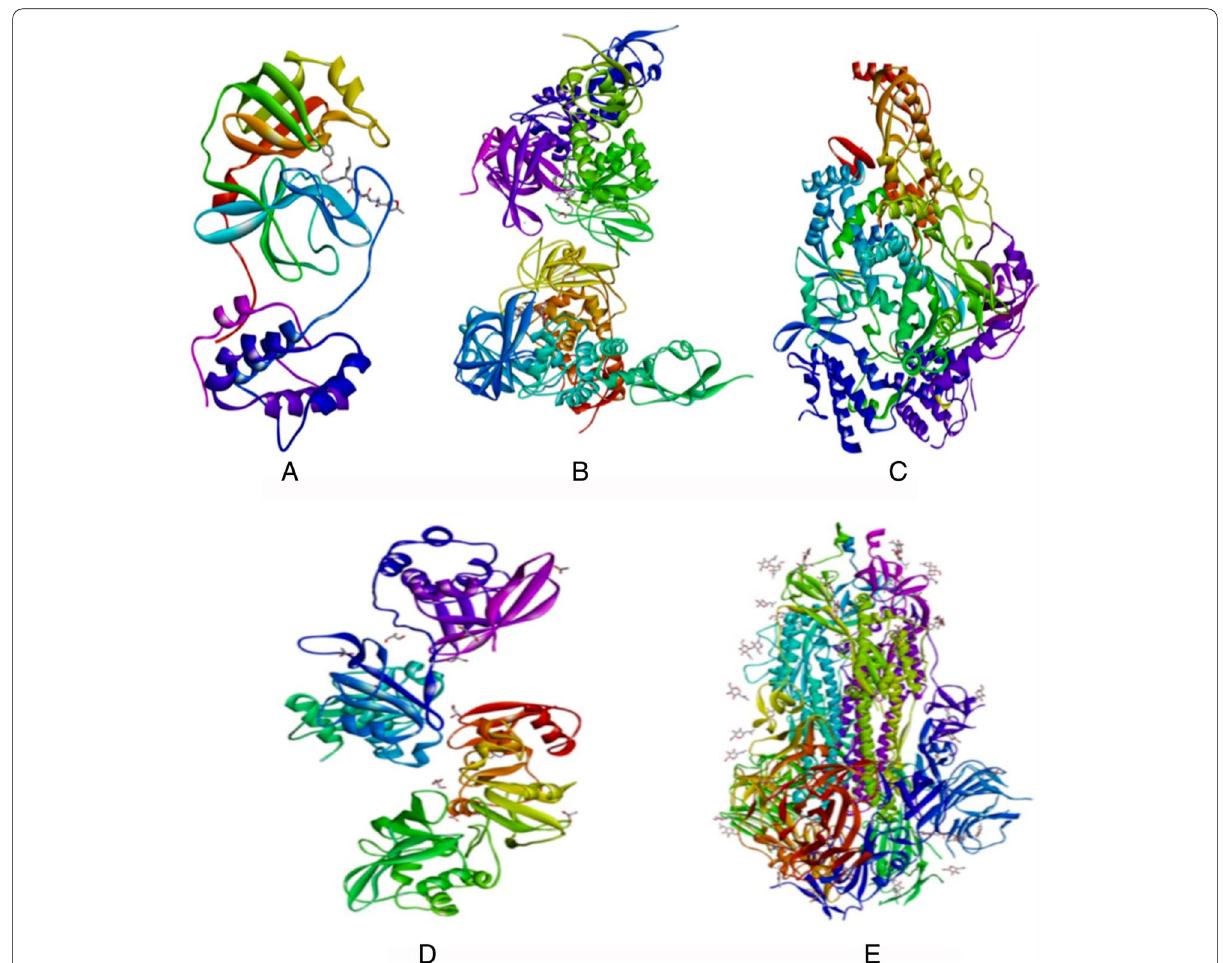
Fig. 2 Structures of SARS-CoV-2 proteins. A Mpro. (PDB: 6LU7). B PLpro (PDB: 6WUU), C Spike glycoprotein (PDB: 6VXX). D NSP15 endoribonuclease (PDB: 6VWW). E RNA-dependent RNA polymerase (PDB: